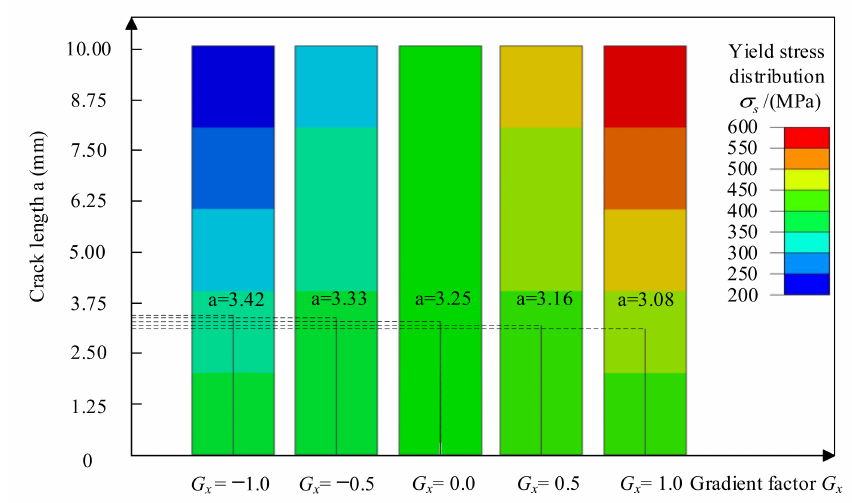
Figure 9. The crack propagation path of the initial crack is parallel to the direction of yield strength